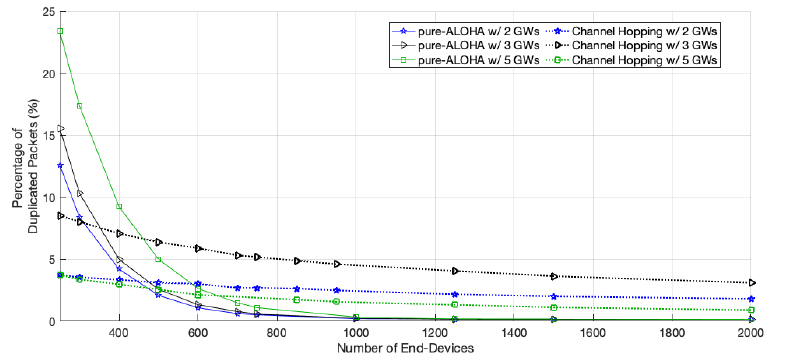
Figure 7. Percentage of duplicated packets among all packets received.